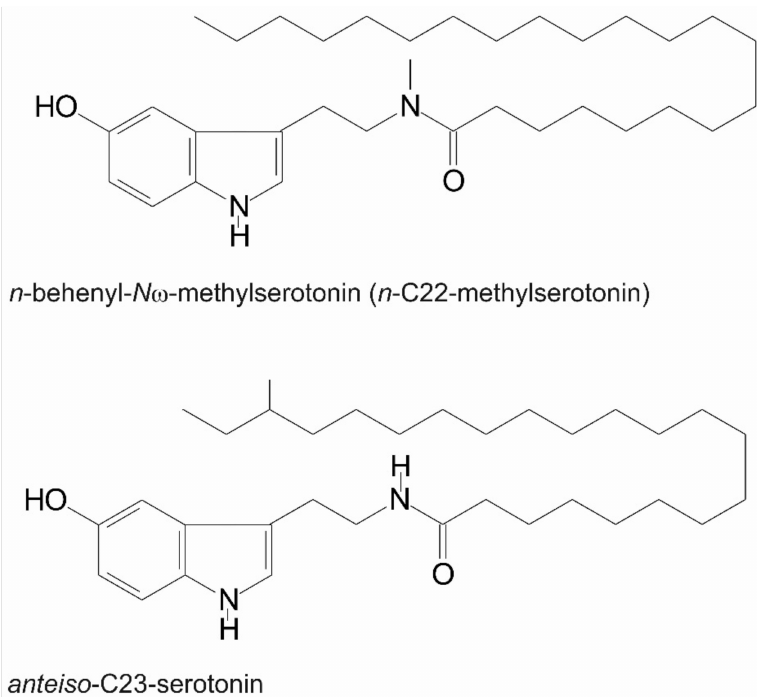
Figure 8. Chemical structure of n -behenyl- N ω -methylserotonin ( n -C22-methylserotonin) and anteiso - C23-serotonin. Table 2. Percent composition (mol%) of N -acylserotonins in the inner seed coats of various lemon varieties and the content of total acylserotonins in the seed coats (means ± SE, n = 3). Acylserotonins with the highest content are marked in bold. n.d.—not